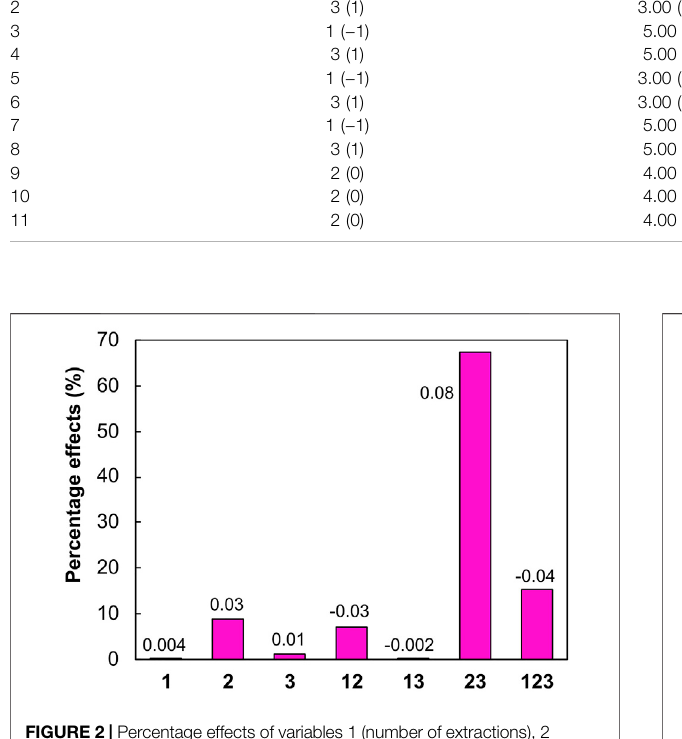
FIGURE 2 | Percentage effects of variables 1 (number of extractions), 2 (solventvolume),and3(sonicationtime),andtheirinteractions.Thecalculated effect values are provided next to each column.